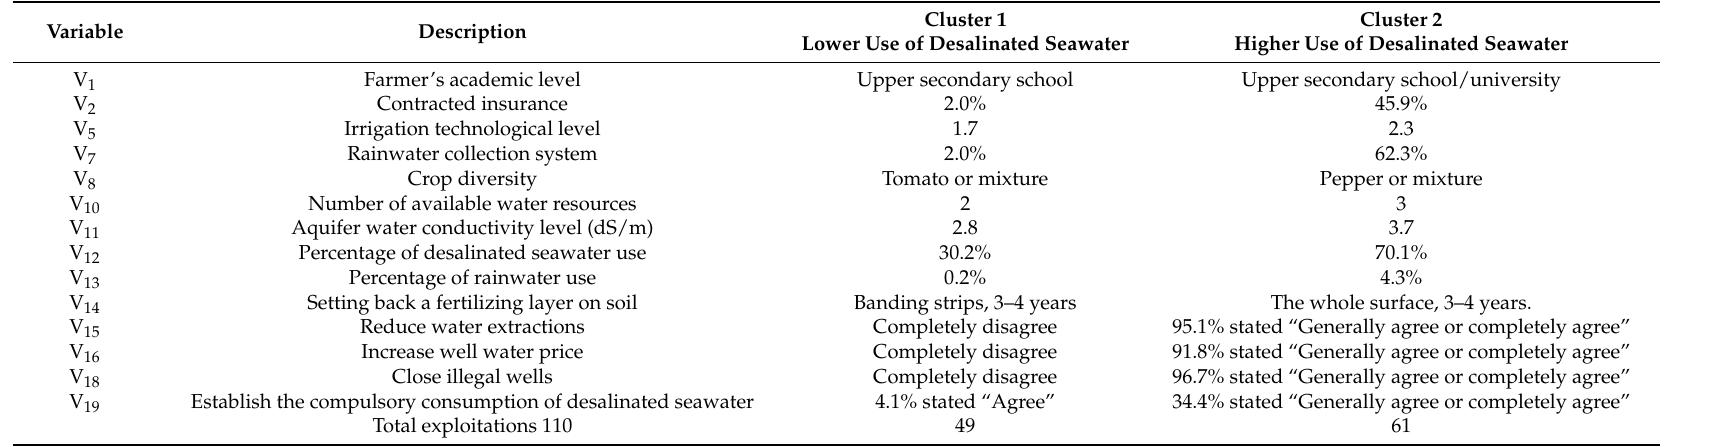
Table 3. Cluster characterization of agriculture